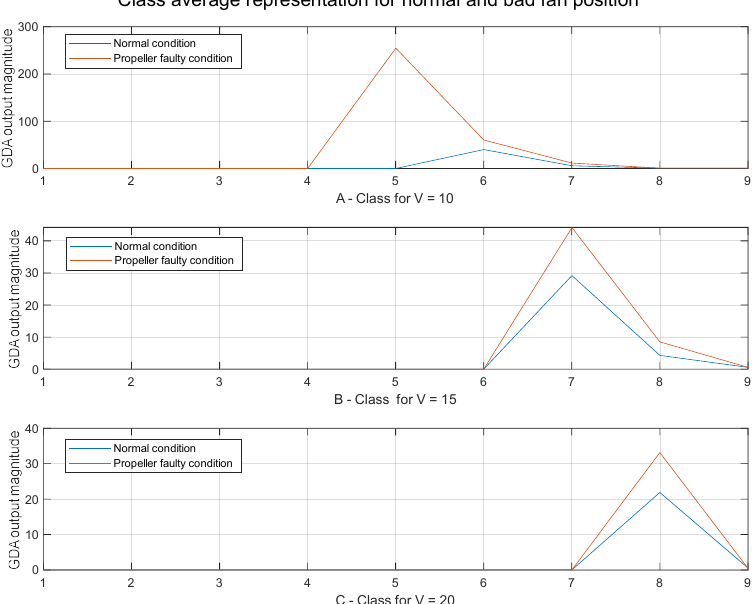
Figure 11. Normalized class average representation for V = 10 (A), V = 15 (B) and V = 20 (C).